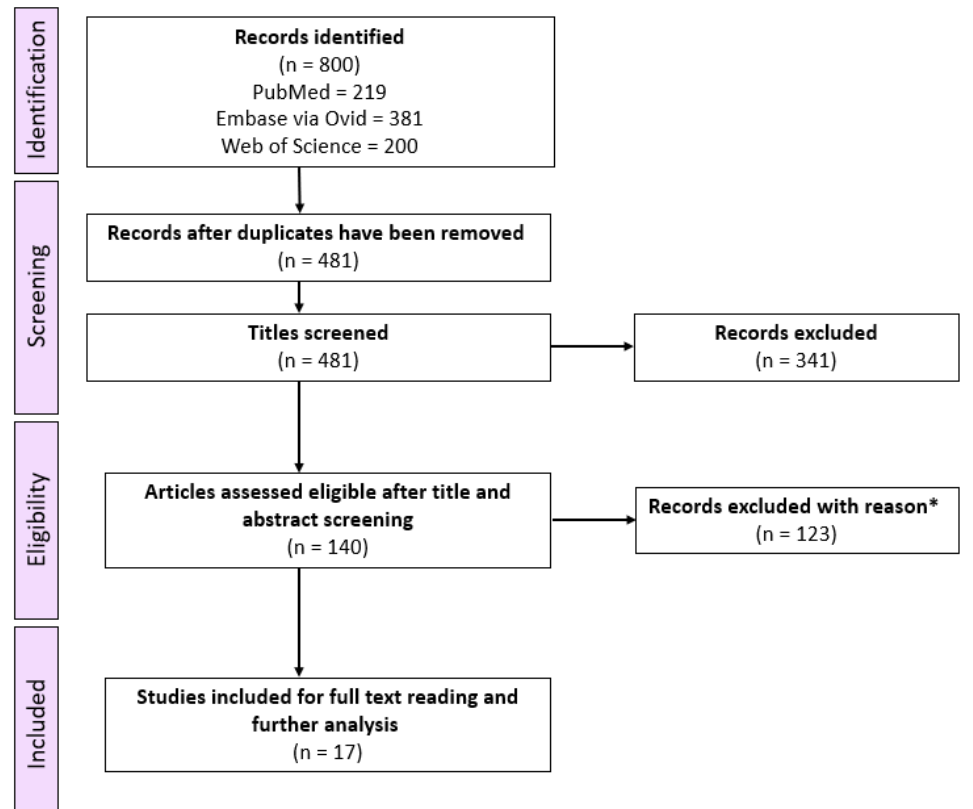
Figure 1. PRISMA flow chart for the selection of papers included in this systematic scoping review. * Excluded records based on the inclusion and exclusion criteria.